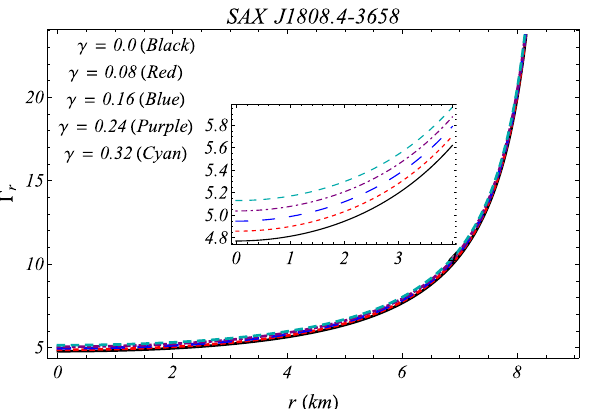
Fig. 4 The relativistic adiabatic index (cid:17) r against r inside the stellar interior